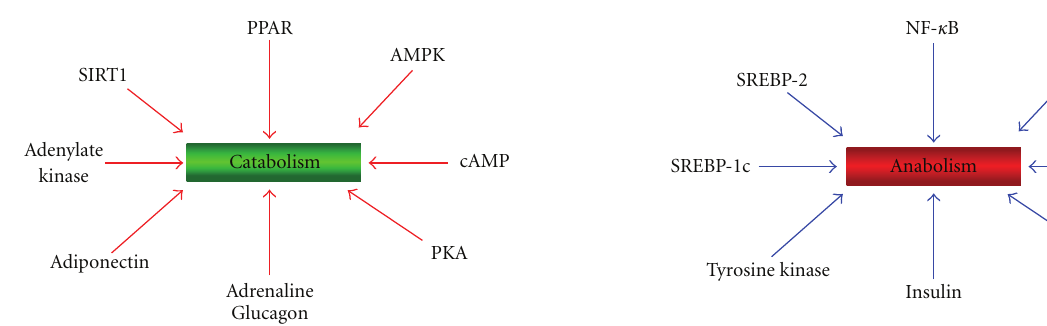
Figure 3: Enzymes, hormones, and transcription factors involved in catabolism. PKA: protein Kinase A, cAMP dependent. AMPK: 5 (cid:2) AMP-activated protein kinase.